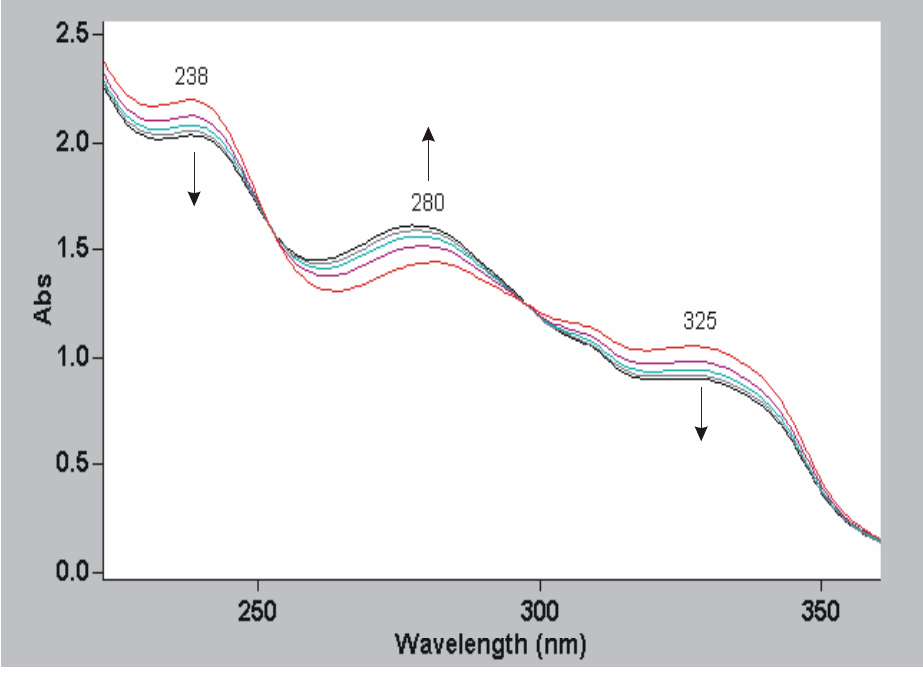
Figure 6. The UV spectra of the decomposition of the complex of Mn(III)- diacetylacetonehydroxylaminmaleate in ethanol with respect to time (15 min).